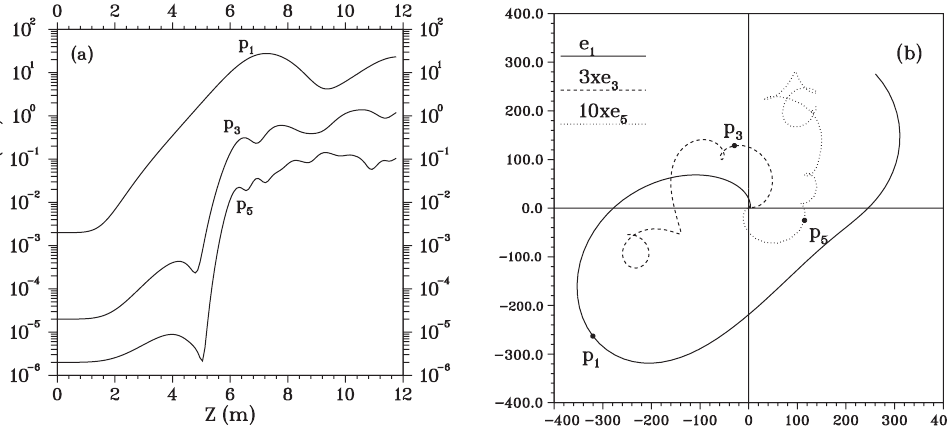
FIG. 16. (a) Evolution of the fundamental, third and fifth harmonics vs the undulator length. (b) Imaginary and real part of the electric fields associated with the power in Fig. (a); the dots mark the values at first maxima. Simulation parameters: (cid:4) 2 : 8 (cid:2) 10 (cid:1) 2 m , (cid:6) ¼ 2 : 35 (cid:2) 10 (cid:1) 3 , (cid:4)